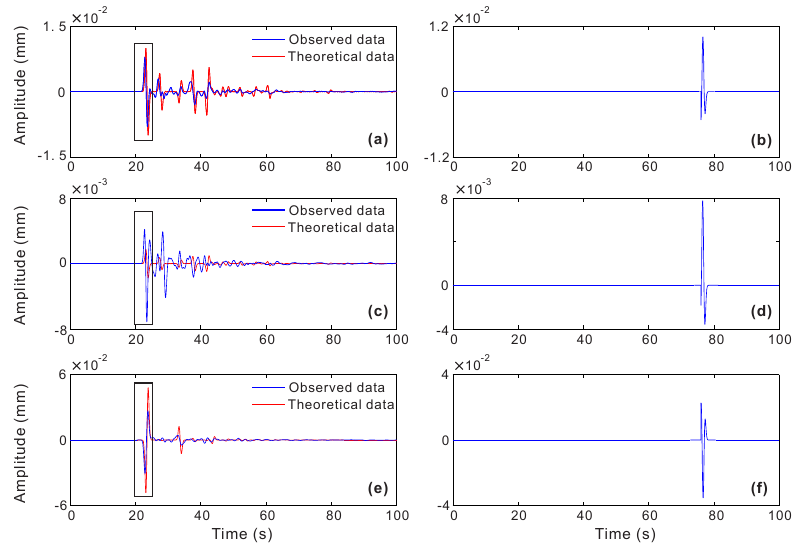
Figure 7. Construction of the adjoint source. In the left panels, the synthetic waveforms from the second example are considered the observed data (blue line), and the synthetic waveforms from the first example are treated as the theoretical data (red line). The rectangular boxes indicate the time window [20, 24] to isolate the waveforms to construct the adjoint source. The top, middle, and bottom panels correspond to the x , y , and z components of the displacement. The three components of the adjoint source–time function is the time-reversed waveform difference between the observed data and the theoretical data.